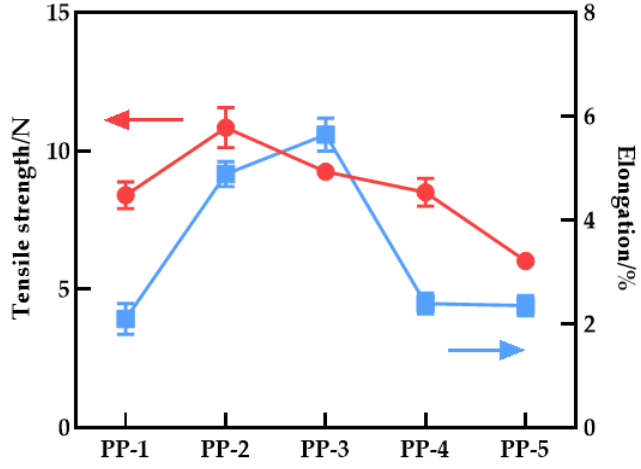
Figure 12. Tensile strength and elongation at break of various PES/PEI membranes.